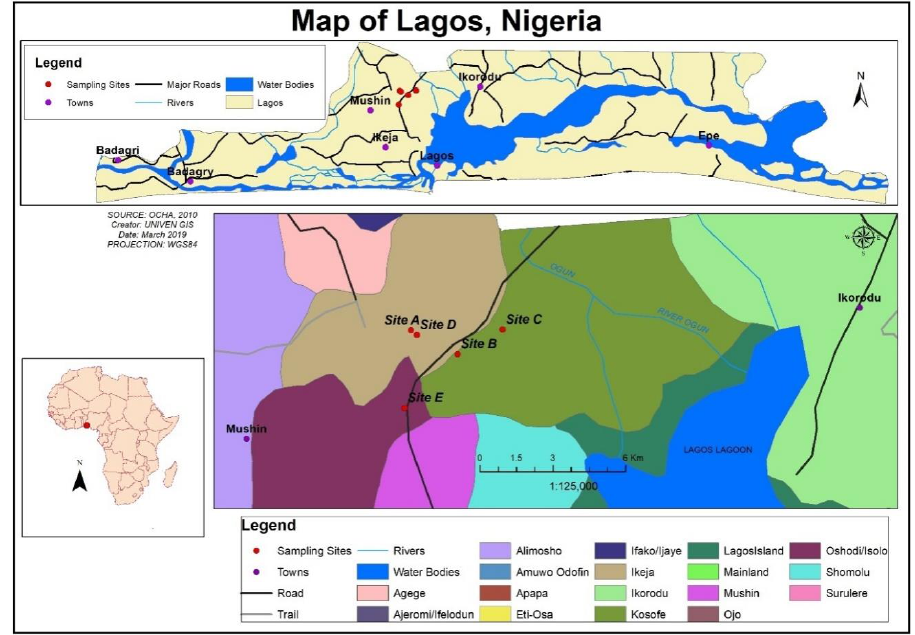
Figure 1. Map showing the study area.